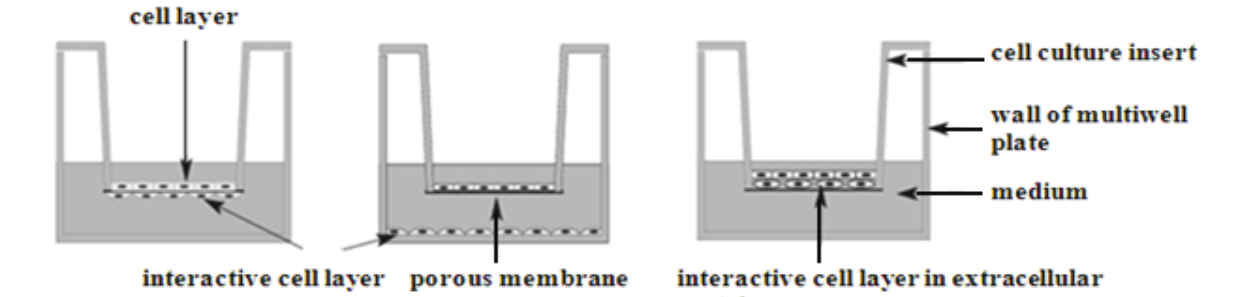
Figure 1. Co-culture set up